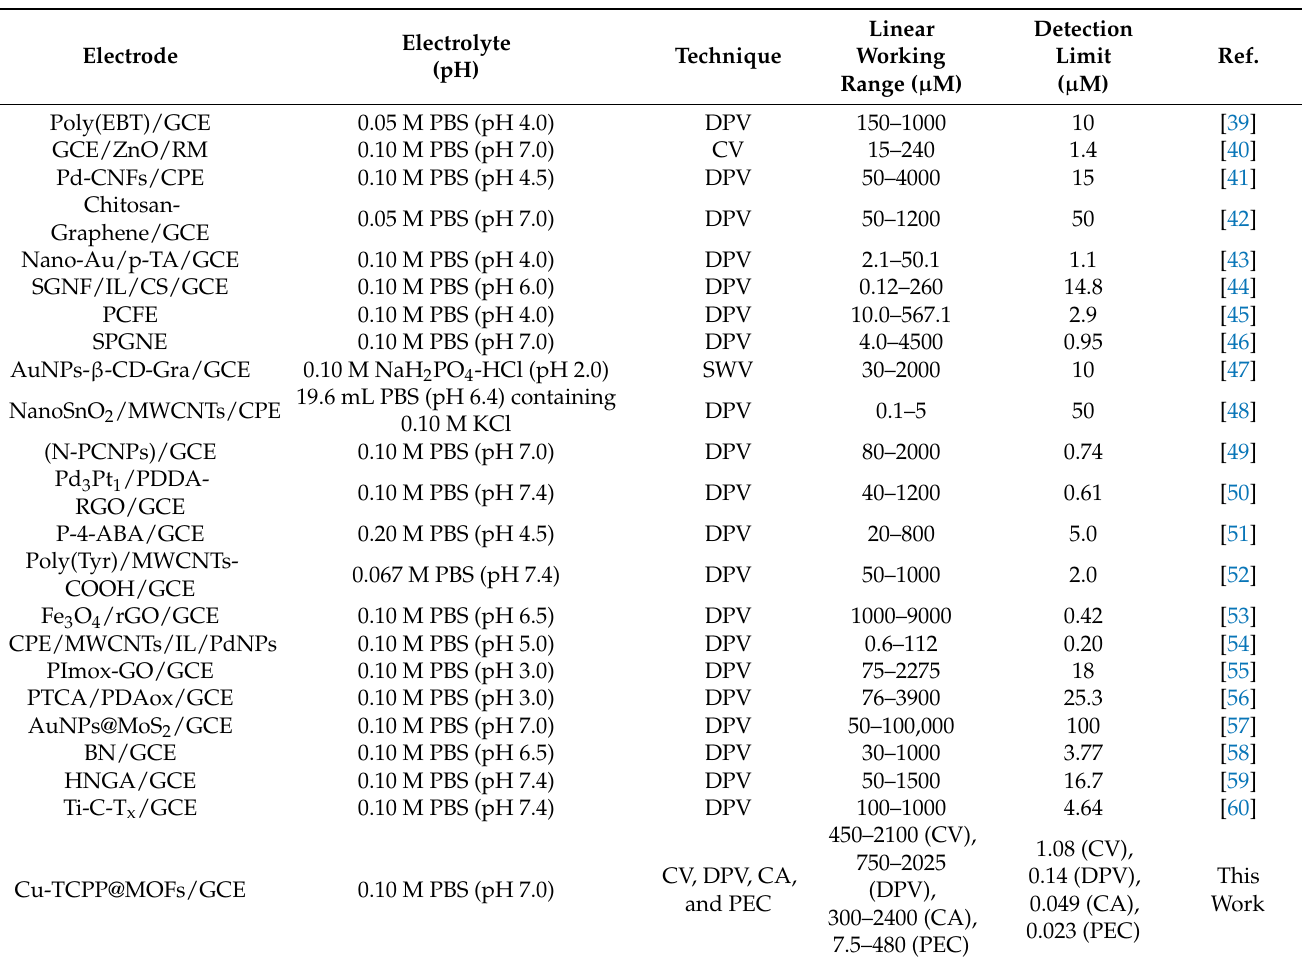
Table 1. Comparison of analytical figure of merits for electrochemical detection of AA using different types of modified